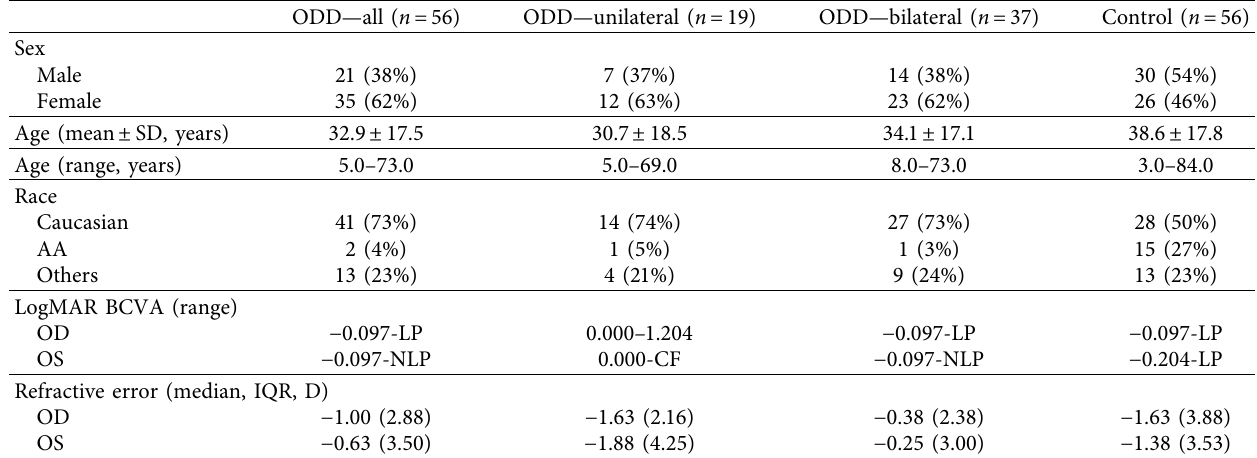
Table 2: Demographic and ophthalmic characteristics of ODD and control patients.